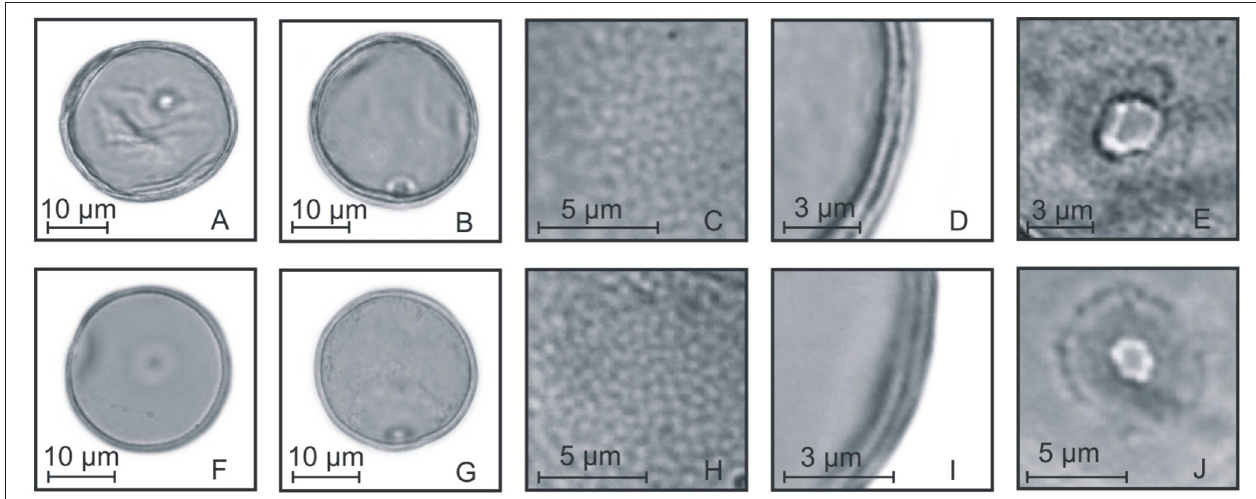
FIGURE 8 | Pollen grains of the subfamily Panicoideae. (A–E) Schizachyrium microstachyum : PV (A) , EV (B) , detail of ornamentation (C) , detail of the thickness of the exine (D) , and detail of the aperture (E) ; (F–J) Arundinella hispida : PV (F) , EV (G) , detail of ornamentation (H) , detail of the thickness of the exine (I) , and detail of the aperture (J) .